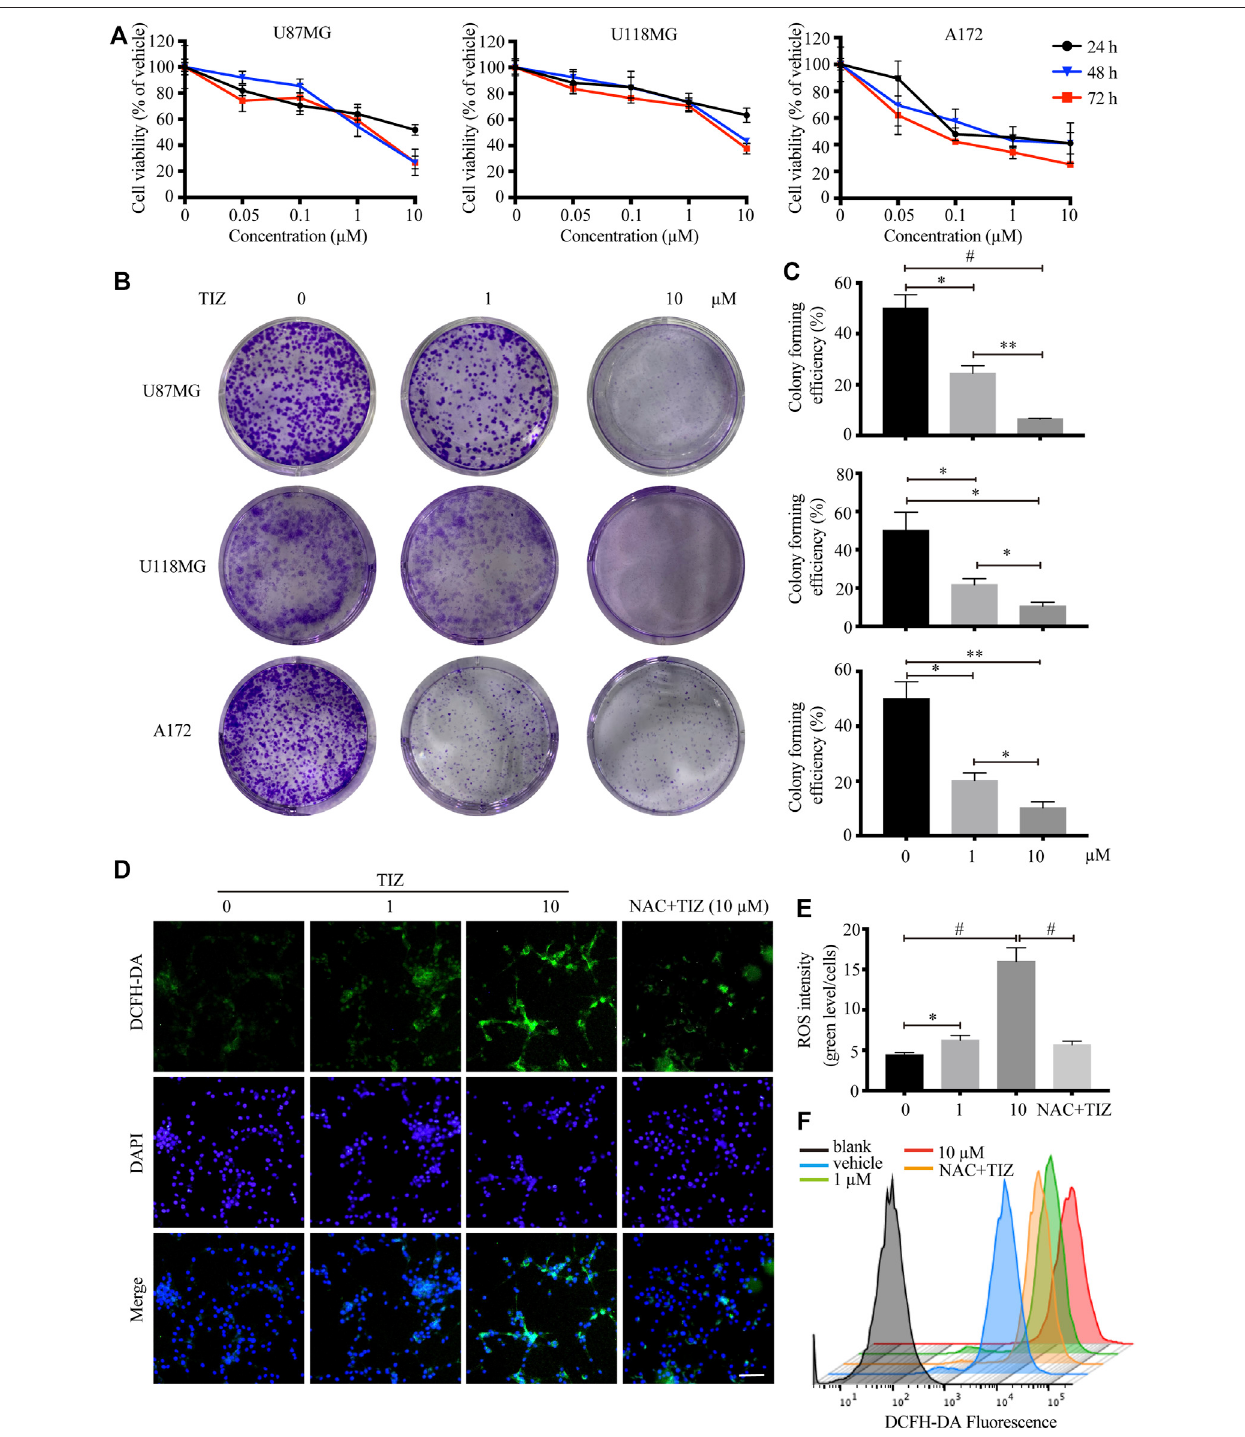
FIGURE 1 | TIZ inhibits GBM cell growth and upregulates ROS levels in vitro . (A) The cell viability of U87MG, U118 MG, and A172 cells was determined by CCK-8 assays after 24, 48, and 72 h of TIZ treatment. (B) Representative images of U87MG colony, U118 MG colony, and A172 colony after the treatment with different concentrations of TIZ. (C) Quanti fi cation of colony area in colony formation assays ( n = 3). (D) Representative images of ROS levels in various U87MG cells after the treatment with the indicated concentrations of TIZ for 24 h, NAC (5 mM) was pretreated for 2 h before TIZ treatment. ROS-positive cells were detected by the indicator dye DCFH-DA. Scale bar = 100 µm. (E) Quanti fi cation of ROS intensities using the ratio of fl uorescent intensity and cell numbers ( n = 5). (F) Flow cytometric measurements of the average fl uorescence intensity of U87MG cells. The experiments were repeated three times independently. Data are presented as the mean ± SD (* p < 0.05, ** p < 0.01, # p < 0.001).